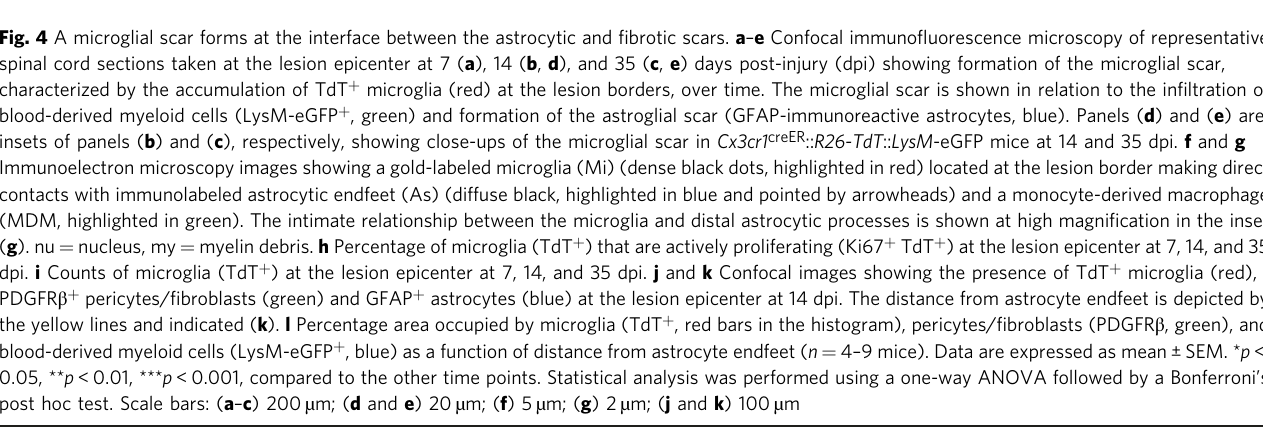
Fig. 4 A microglial scar forms at the interface between the astrocytic and fi brotic scars. a – e Confocal immuno fl uorescence microscopy of representative spinal cord sections taken at the lesion epicenter at 7 ( a ), 14 ( b , d ), and 35 ( c , e ) days post-injury (dpi) showing formation of the microglial scar, characterized by the accumulation of TdT + microglia (red) at the lesion borders, over time. The microglial scar is shown in relation to the in fi ltration of blood-derived myeloid cells (LysM-eGFP + , green) and formation of the astroglial scar (GFAP-immunoreactive astrocytes, blue). Panels ( d ) and ( e ) are insets of panels ( b ) and ( c ), respectively, showing close-ups of the microglial scar in Cx3cr1 creER :: R26-TdT :: LysM -eGFP mice at 14 and 35 dpi. f and g Immunoelectron microscopy images showing a gold-labeled microglia (Mi) (dense black dots, highlighted in red) located at the lesion border making direct contacts with immunolabeled astrocytic endfeet (As) (diffuse black, highlighted in blue and pointed by arrowheads) and a monocyte-derived macrophage (MDM, highlighted in green). The intimate relationship between the microglia and distal astrocytic processes is shown at high magni fi cation in the inset ( g ). nu = nucleus, my = myelin debris. h Percentage of microglia (TdT + ) that are actively proliferating (Ki67 + TdT + ) at the lesion epicenter at 7, 14, and 35 dpi. i Counts of microglia (TdT + ) at the lesion epicenter at 7, 14, and 35 dpi. j and k Confocal images showing the presence of TdT + microglia (red), PDGFR β + pericytes/ fi broblasts (green) and GFAP + astrocytes (blue) at the lesion epicenter at 14 dpi. The distance from astrocyte endfeet is depicted by the yellow lines and indicated ( k ). l Percentage area occupied by microglia (TdT + , red bars in the histogram), pericytes/ fi broblasts (PDGFR β , green), and blood-derived myeloid cells (LysM-eGFP + , blue) as a function of distance from astrocyte endfeet ( n = 4 – 9 mice). Data are expressed as mean ± SEM. * p < 0.05, ** p < 0.01, *** p < 0.001, compared to the other time points. Statistical analysis was performed using a one-way ANOVA followed by a Bonferroni ’